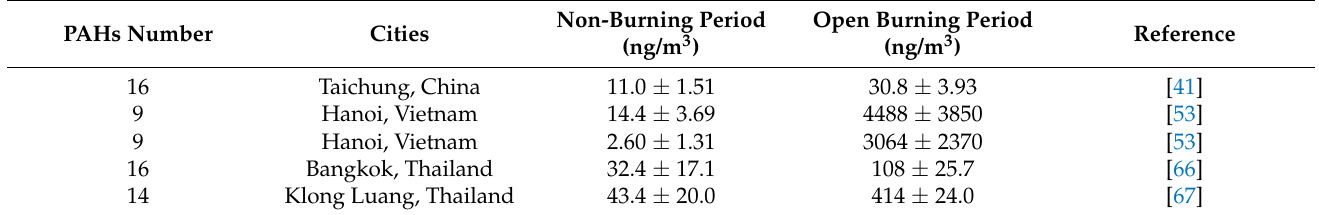
Table 3. Comparison of the concentration of PAHs in non-burning period with open burning